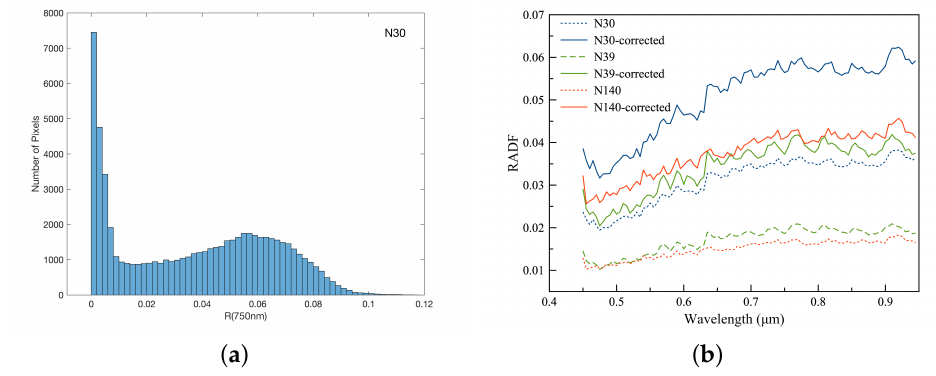
Figure 7. ( a ) Reflectance histogram of N30 detection area at 750 nm. ( b ) Shadow-corrected and uncorrected spectra of N30, N39, N140 in the VIS/NIR band after photometric